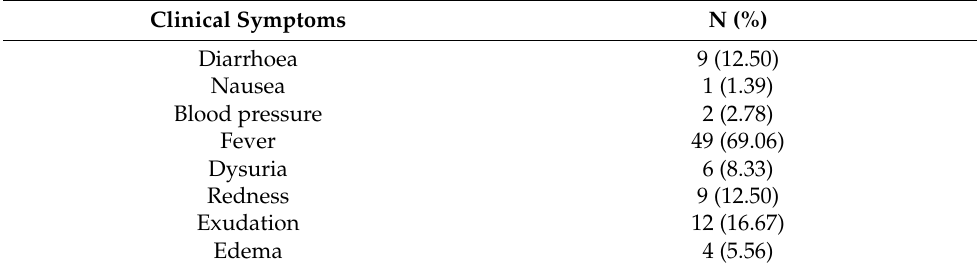
Table 6. The clinical symptoms in nosocomial